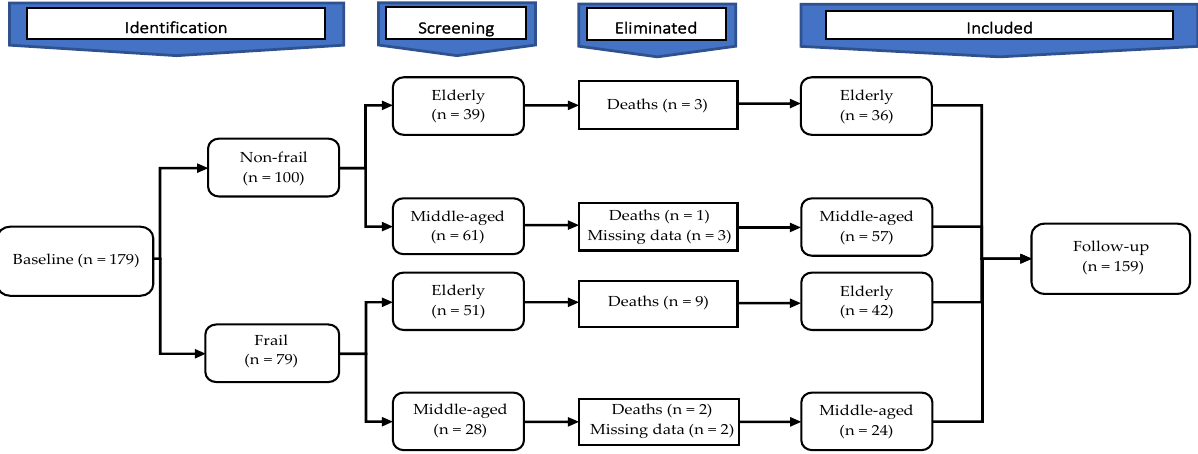
Figure 1. The chart with the sample evolution at one ‐ year follow ‐ up. The mortality rate after one year from baseline was 8.4%: 13.3% in the elderly group and 3.4% in the middle ‐ aged group. Five individuals had missing data from middle ‐ aged group (3 non ‐ frail and 2 frail) at follow ‐ up (3.1%). The survival functions (Kaplan–Meier test) are presented in Figure 2. The test of equality of survival distribution (Log Rank)